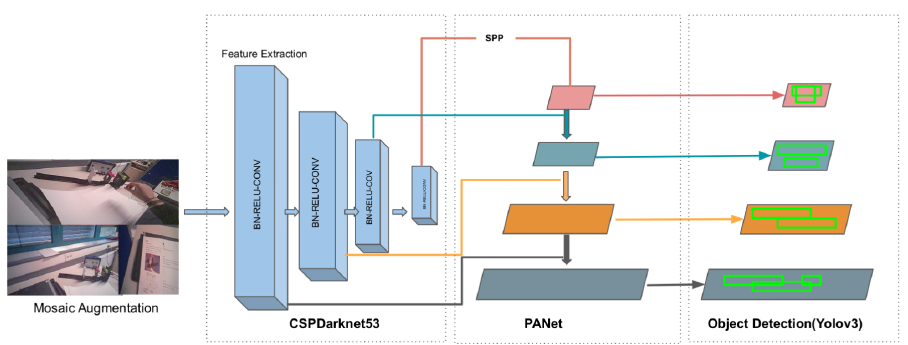
Figure 4. Architecture of YOLO v4.